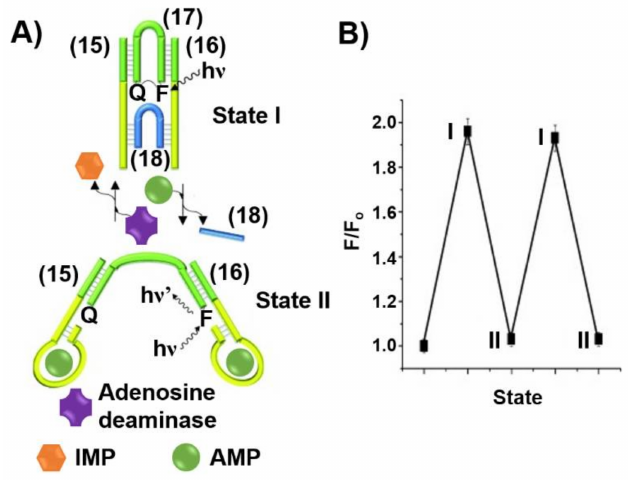
Figure 15. ( A ) An AMP/Adenosine deaminase triggered reversible opening of a DNA tweezer machine. The formation of the AMP/AMP aptamer complexes with the tweezer “arms” open the tweezer while the adenosine deaminase catalyzed conversion of AMP to inosine monophosphate (IMP) separates the AMP/AMP aptamer complexes and restores the closed tweezer. The opening and closure of the tweezer is recorded by following the fluorescence of the Cy5 fluorophore, that is the spatial separation from the quencher unit controls the fluorescence intensity transduced by the fluorophore. ( B ) Cyclic fluorescence changes transduced from the nanodevice upon opening (I) and closure (II). Reproduced with permission from ref. [204]. Copyright 2009